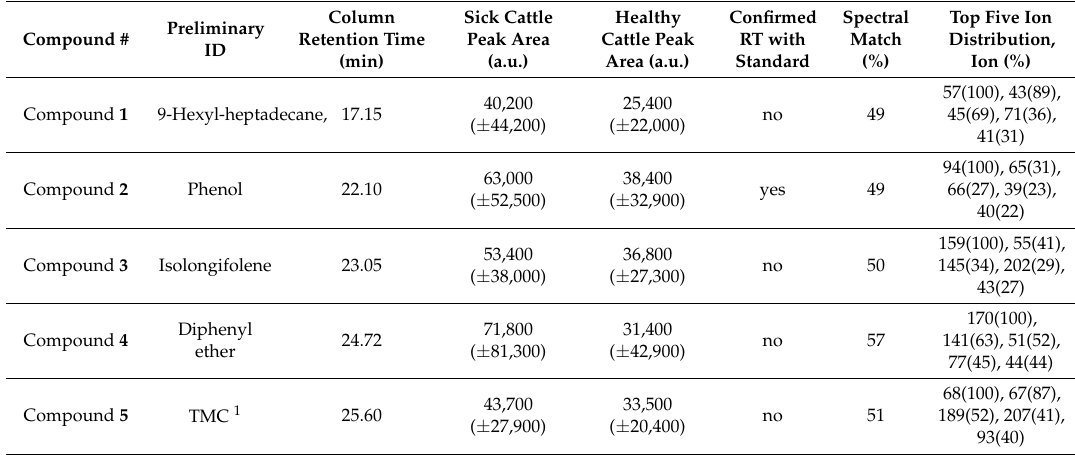
Table 2. Preliminary compound identification for markers in cattle serum samples (Figure